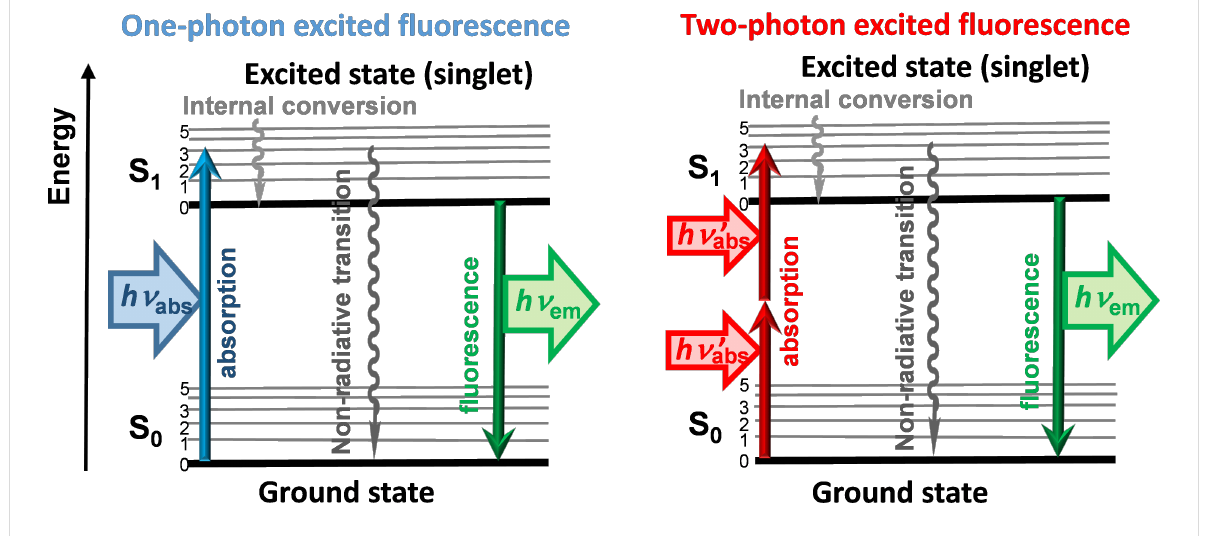
Figure 1: Jablonski-type diagram displaying the classical one-photon excited fluorescence (left), and the less-classical two-photon excited fluores- cence (right).